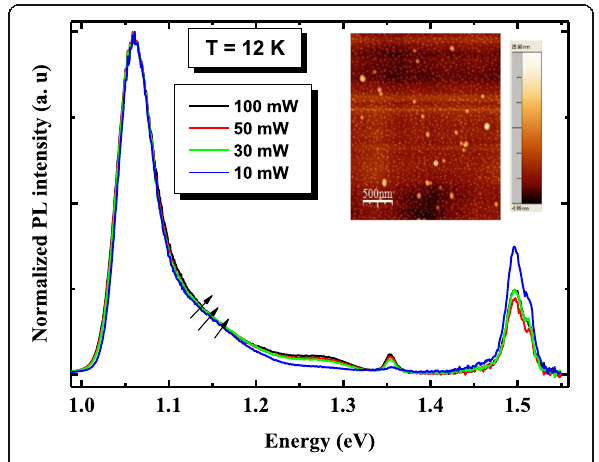
Fig. 5 Excitation power-dependent normalized PL spectra from the InAs/InGaAs QD heterostructure measured at 12 K